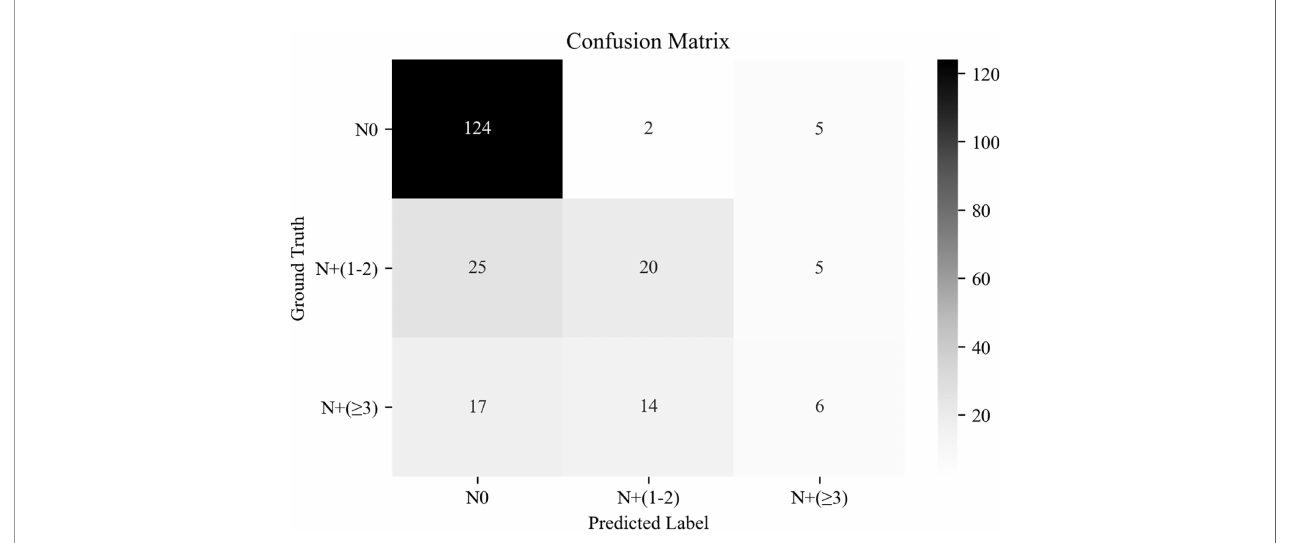
FIGURE 5 | The confusion matrix of predicting axillary lymph node (ALN) status between disease-free axilla (N0), low metastatic burden of axillary disease (N+(1 − 2)), and heavy metastatic burden of axillary disease (N+( ≥